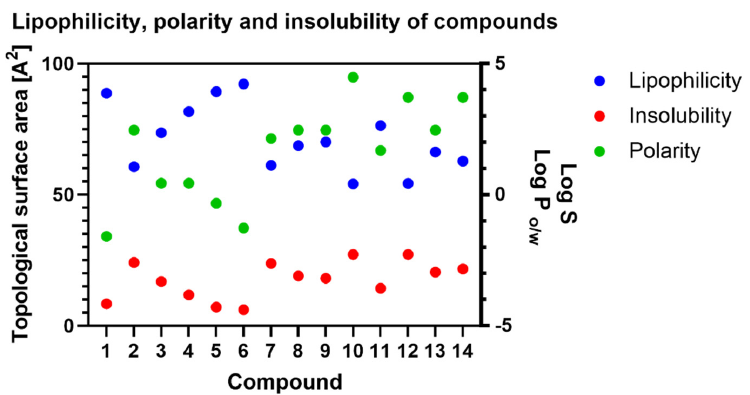
Figure 6. Changes in lipophilicity, polarity and insolubility of tested compounds. Lipophilicity is measured as a Log P parameter, polarity as a topological surface area (TPSA) and insolubility as a Log S value.